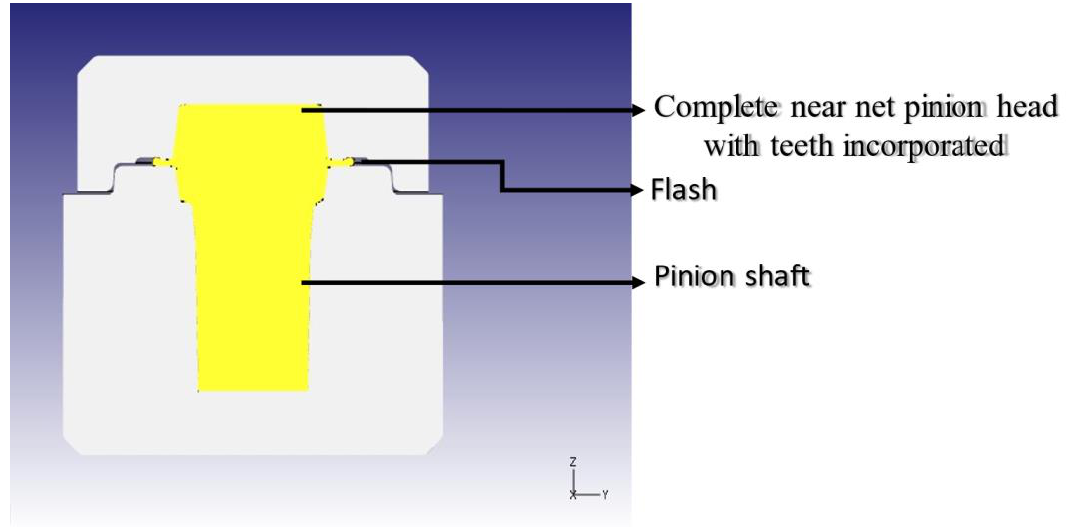
Figure 16. Near-net pinion shaft with teeth formation incorporated.